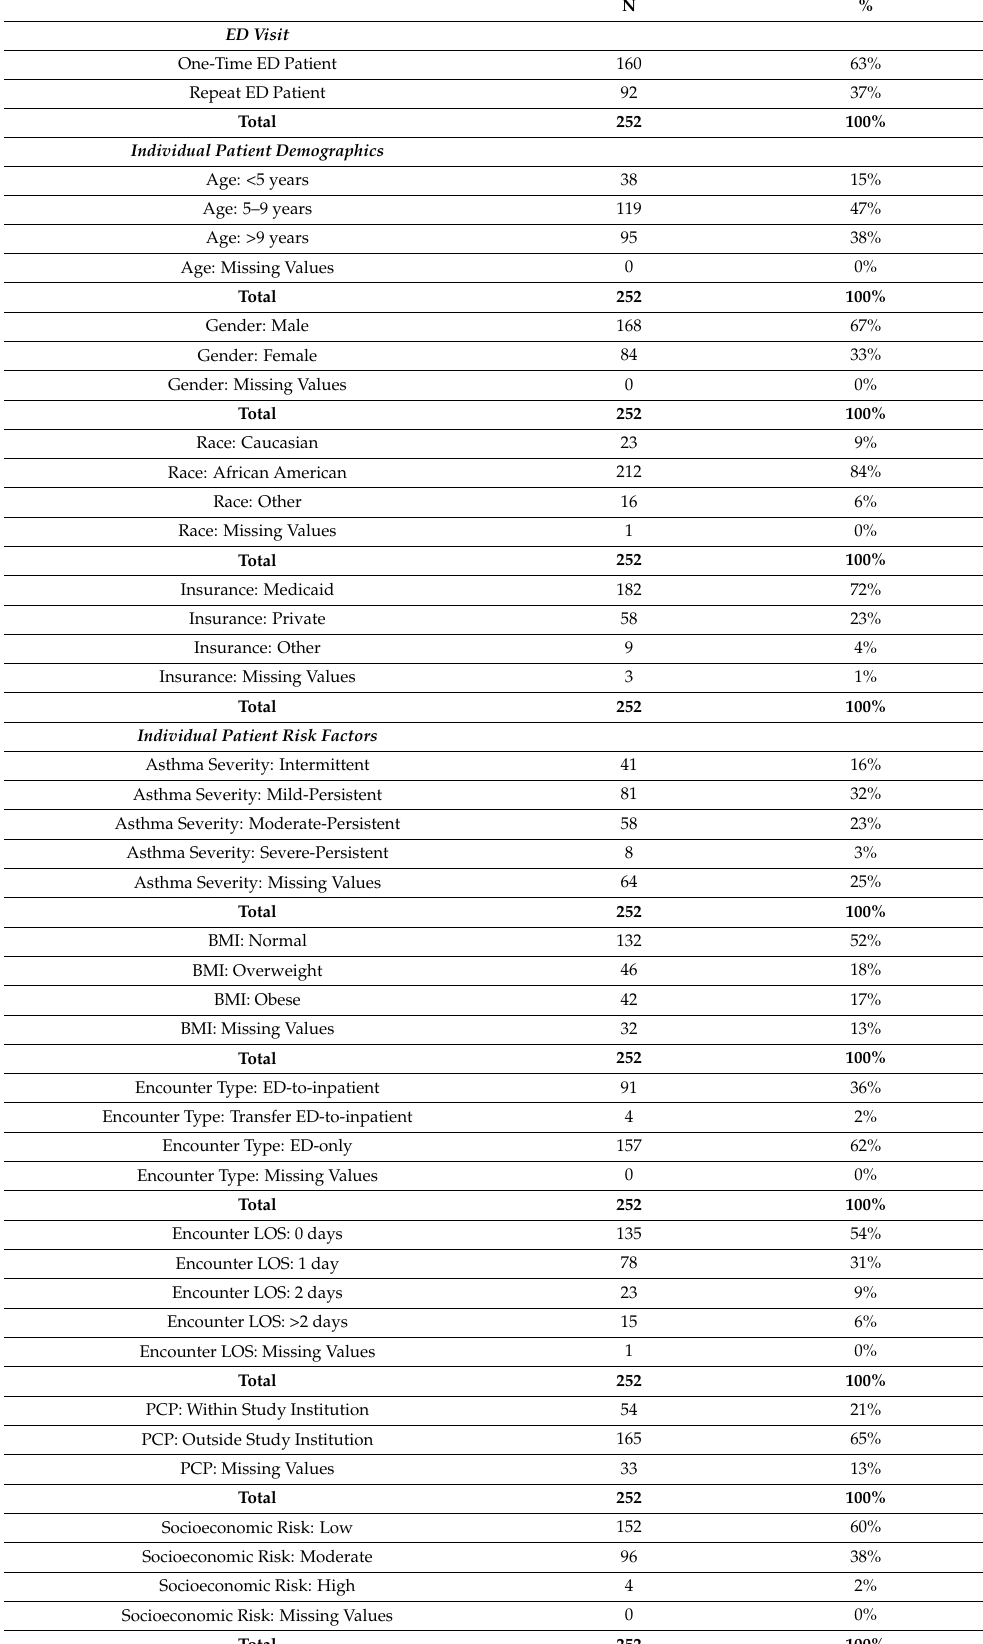
Table 1. Summary data on study variables: Round 1 analysis (0–17